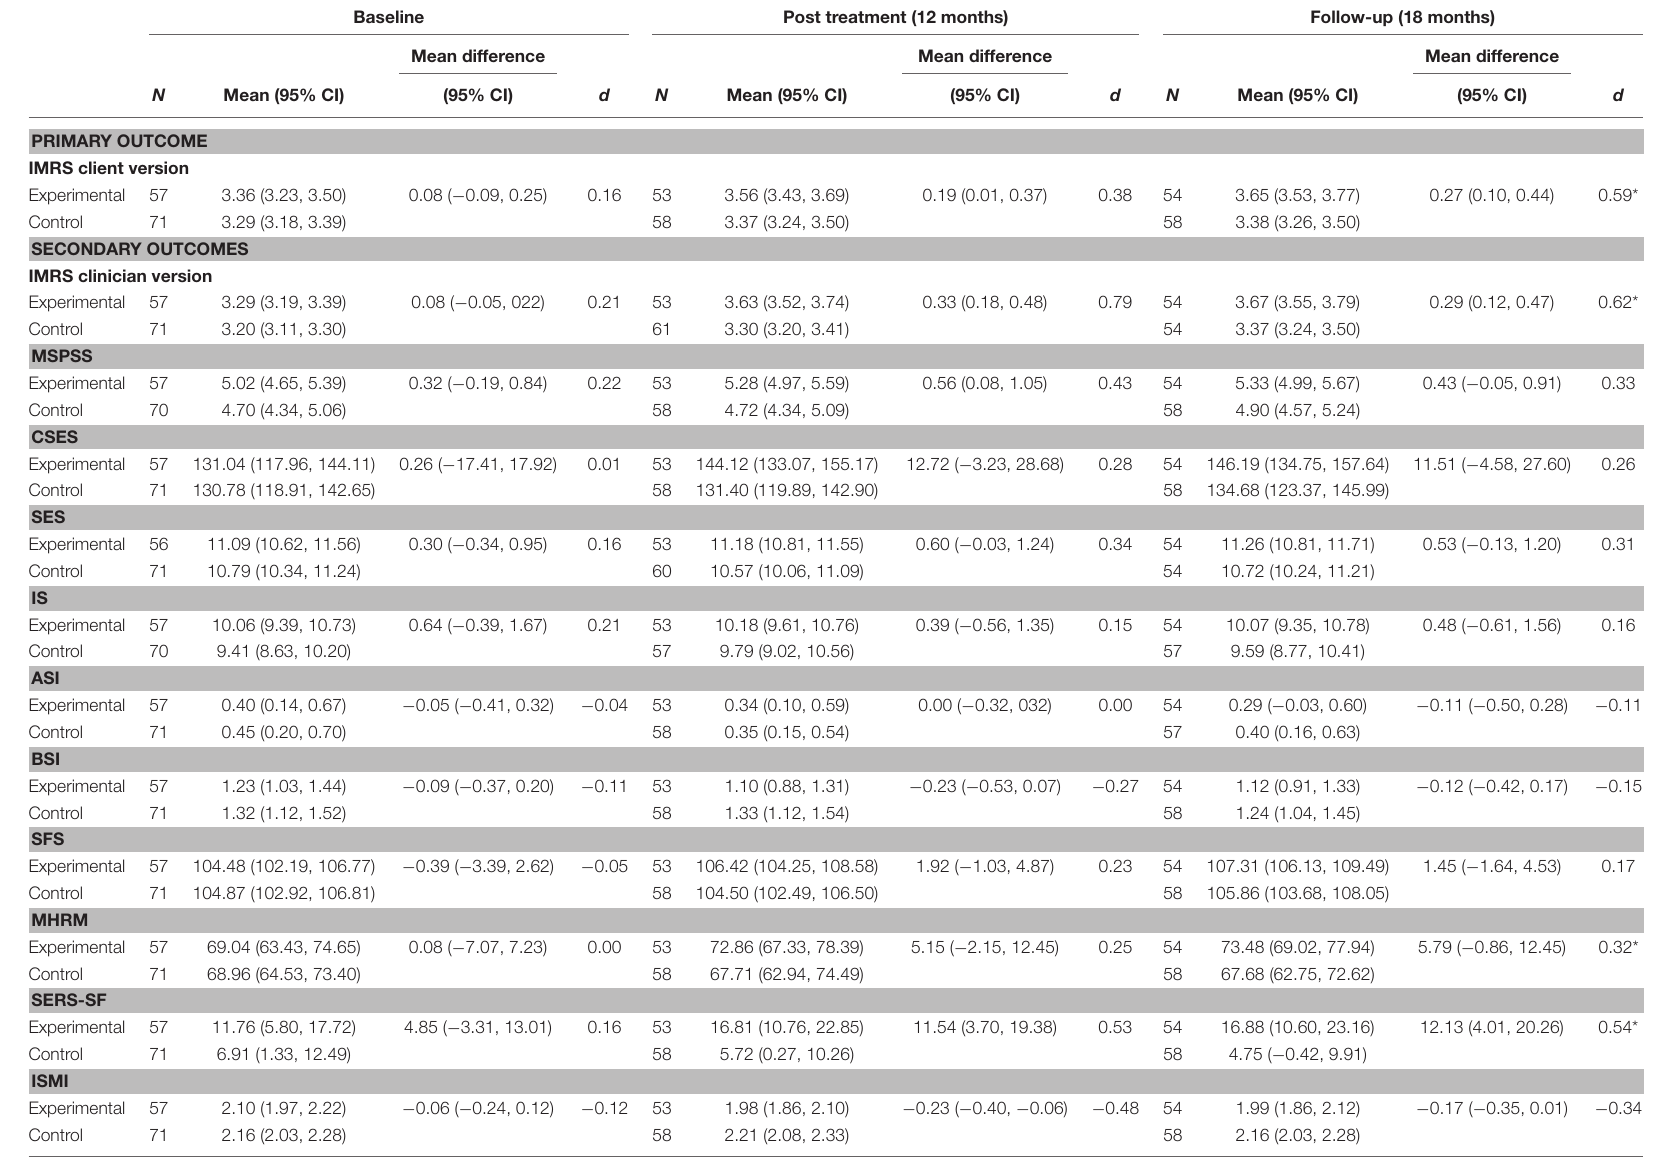
TABLE 7 | Estimated outcomes as a function of IMR, estimated from linear mixed models in the completers